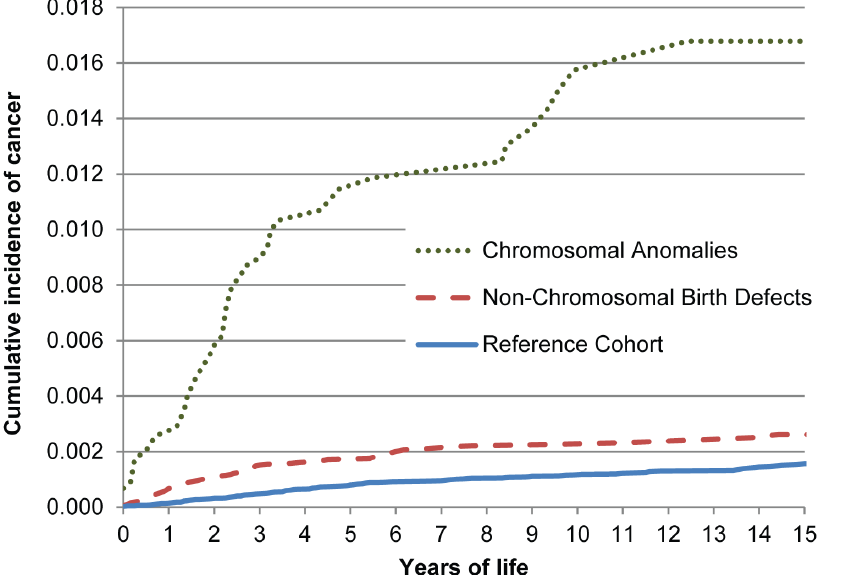
Figure 3. Cumulative incidence of cancer prior to age 15 years in children with non-chromosomal birth defects and with chromosomal anomalies, UTAZIA study. Cumulative incidence is expressed as a proportion (0.01=1 percent).